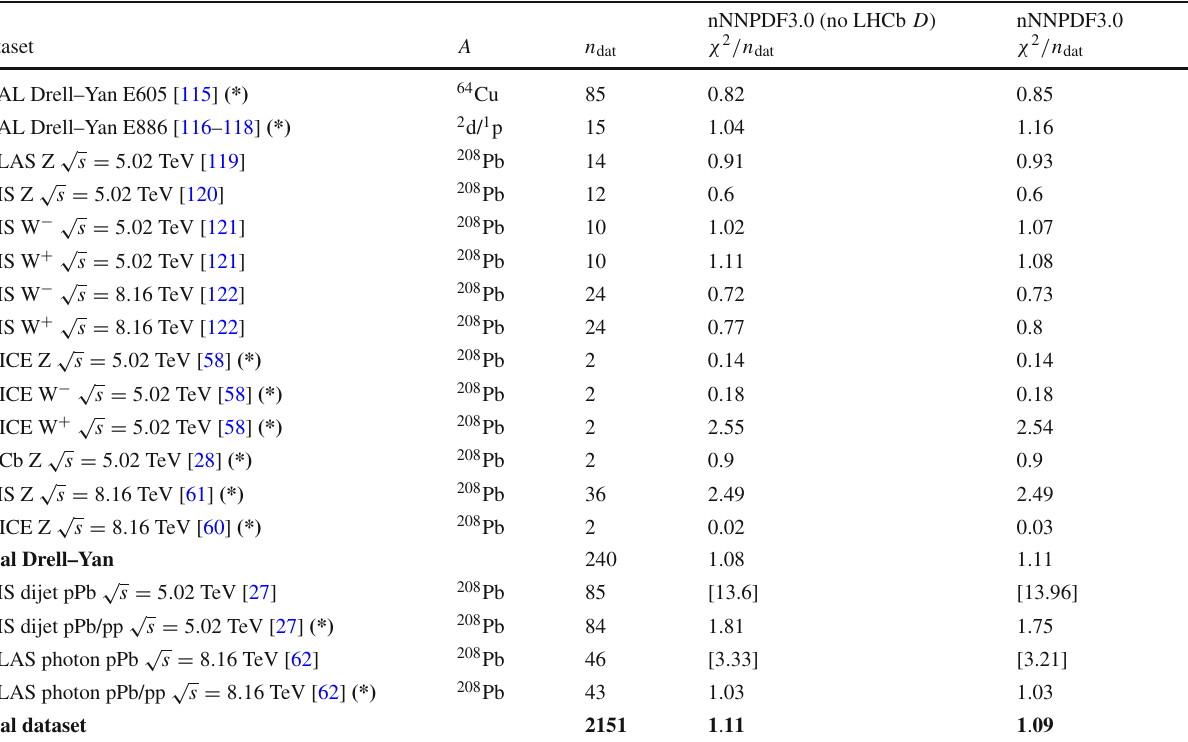
Table 5 Same as Table 4 now for the fixed-target and LHC DY pro- duction datasets, the CMS dijet cross-sections, and the ATLAS direct photon production measurements. The last row indicates the values cor- responding to the global dataset. Values indicated within brackets ([ ])